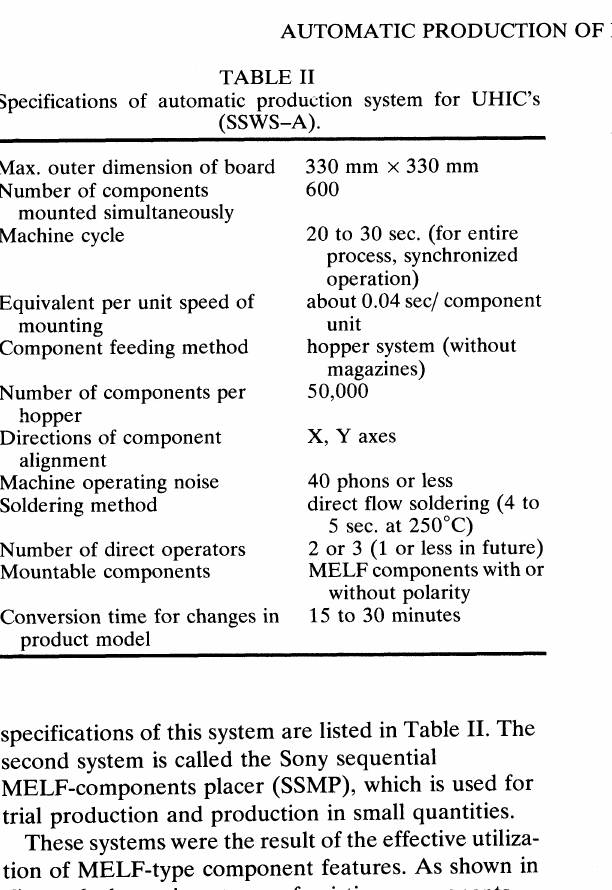
Specifications of automatic production system for UHIC’s (SSWS-A).